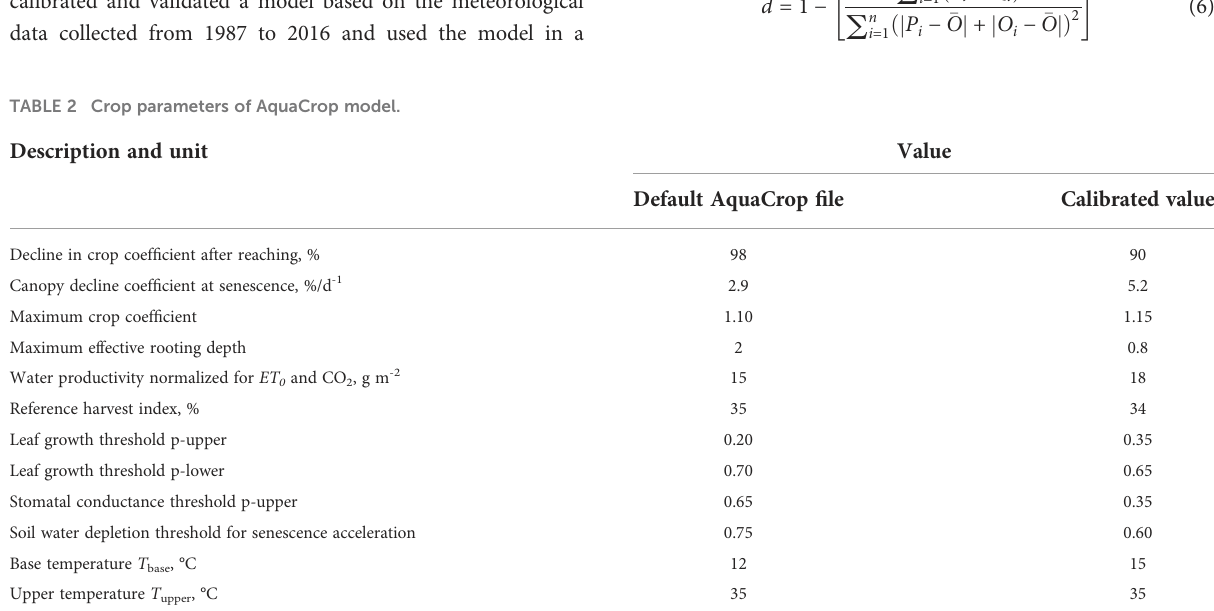
TABLE 2 Crop parameters of AquaCrop